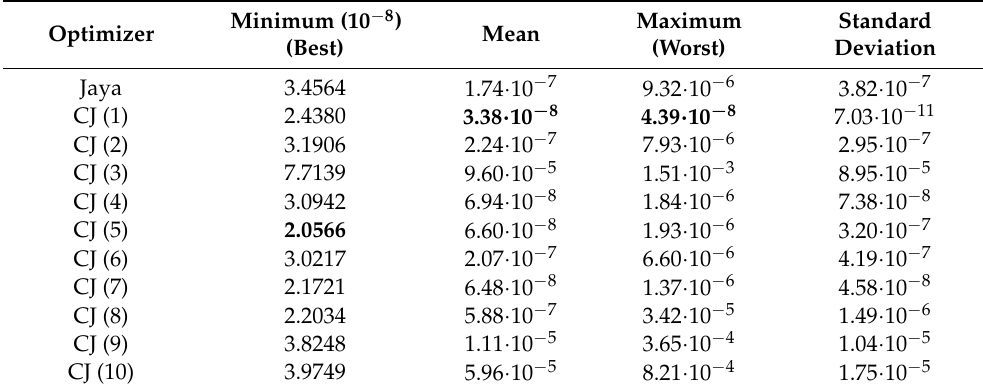
Table 3. Optimization results for the Loney’s solenoid in 50 runs considering the objective function to be minimized, given by f ( s , l ). Data in bold font indicates the smaller